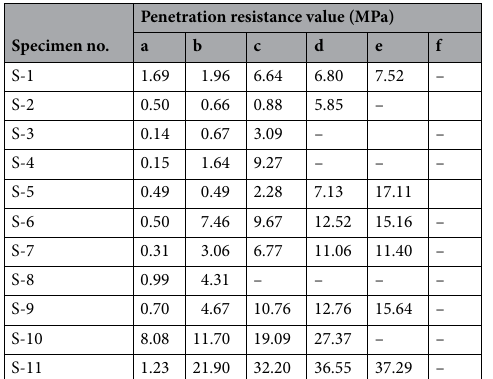
Table 5. Penetration resistance values determined for the tested specimens. Missing values are from specimens in which fracturing occurred during penetration testing.